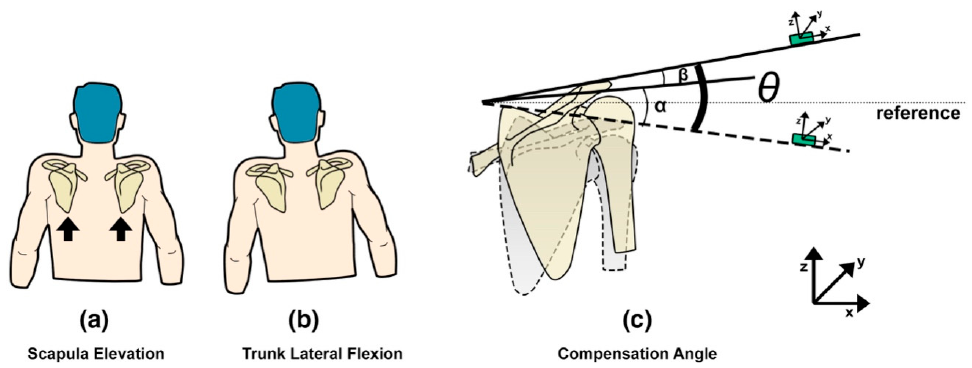
Figure 2. Calibration model of the compensatory movement from shoulder girdle.